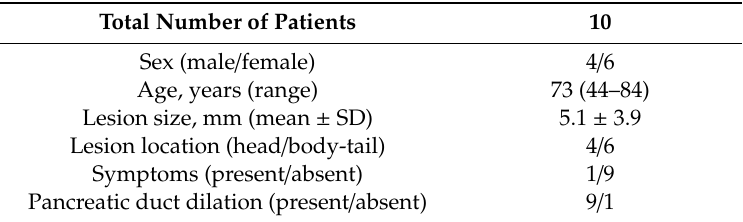
Table 4. Characteristics of patients with pancreatic cancer measuring ≤ 10 mm.